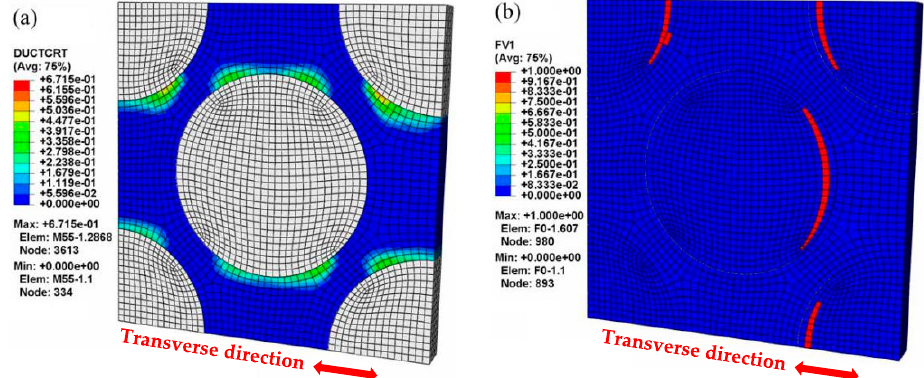
Figure 9. Microscopic damage and failure at the final stage of the transverse tensile process (MFEM- B model): ( a ) matrix damage ( 𝜀 (cid:3021) = 0.26%); ( b ) fiber fracture ( 𝜀 (cid:3021) = 0.26%).